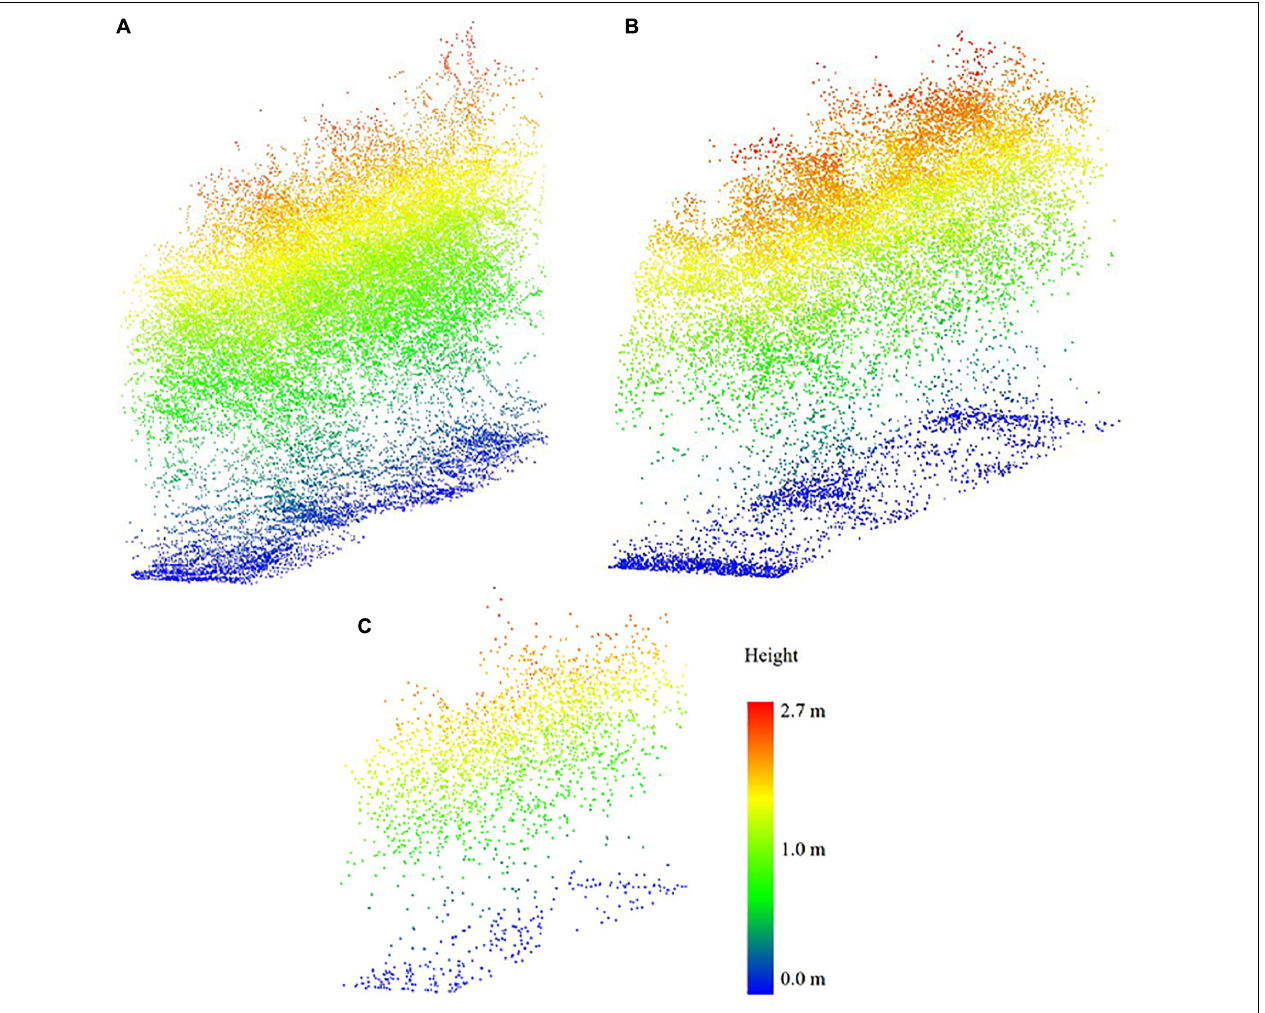
FIGURE 5 | Example sensor point cloud sample data from (7/20/2020) from (A) PhenoRover, (B) UAV-2, and (C) UAV-1.